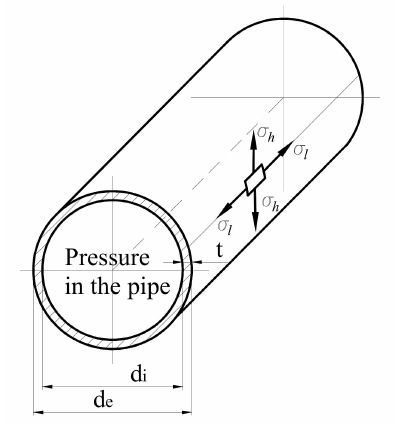
Figure 6. The hoop and the longitudinal stresses of the